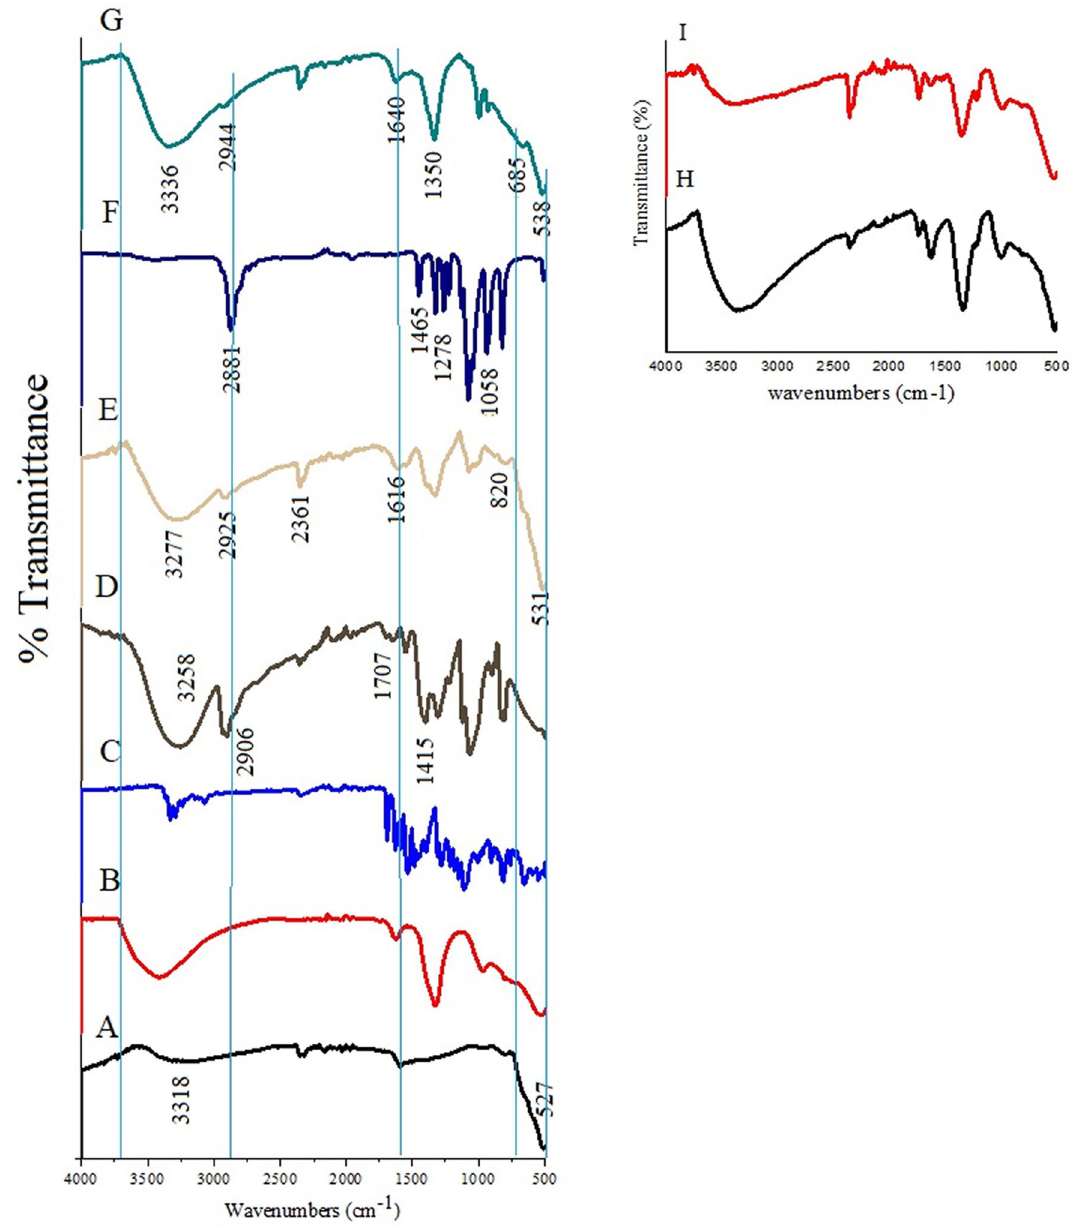
Figure 3. Fourier transform infrared spectra for ( A ) iron oxide nanoparticles; ( B ) MLDH; ( C ) pure sorafenib; ( D ) pure PVA; ( E ) core–shell nanoparticles (FPVASO-MLDH); ( F ) pure PEG; ( G ) core–shell nanoparticles (FPEGSO-MLDH). Inset shows the FTIR spectra of ( H ) FPEGSO and ( I )